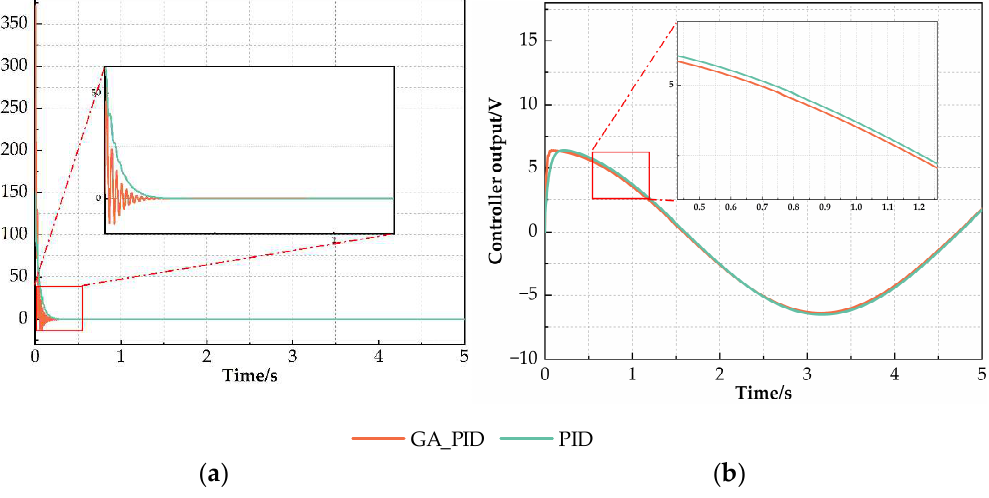
Figure 10. Output of PID and GA-optimized PID controllers. ( a ) Controller output under step signal input; ( b ) Controller output under sinusoidal signal input.